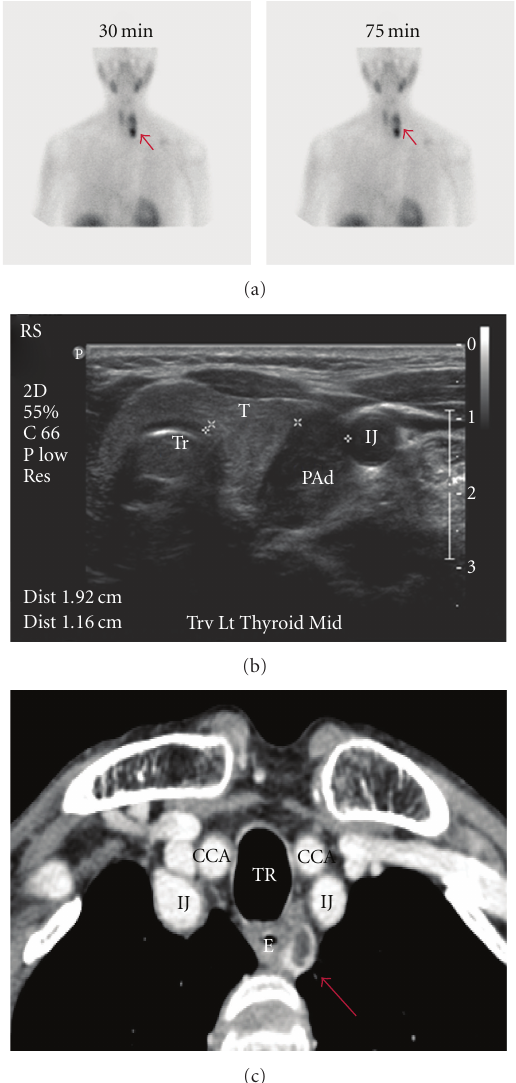
Figure 1: Preoperative imaging in primary hyperparathyroidism. (a) Sestamibi with SPECT displaying focal retention in the left lower position (arrow) after 30 and 75 minutes washout, respectively. (b) Corresponding cervical ultrasound from the same patient showing a large hypoechoic cystic parathyroid adenoma (arrow). The left thyroid lobe (T), trachea (Tr), and left internal jugular vein (IJ) are indicated. (c) Four-dimensional parathyroid CT scan depicting an ectopically positioned left superior paraesophageal parathyroid adenoma (arrow). IJ: internal jugular vein; T: trachea; E: esophagus; CCA: common carotid